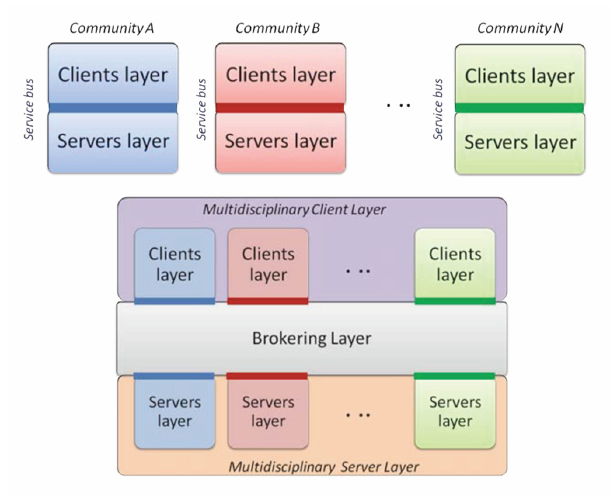
Fig. 2. Community Layered C–S architectures and the broker archi- tecture for multi-disciplinary environments (Nativi et al.,